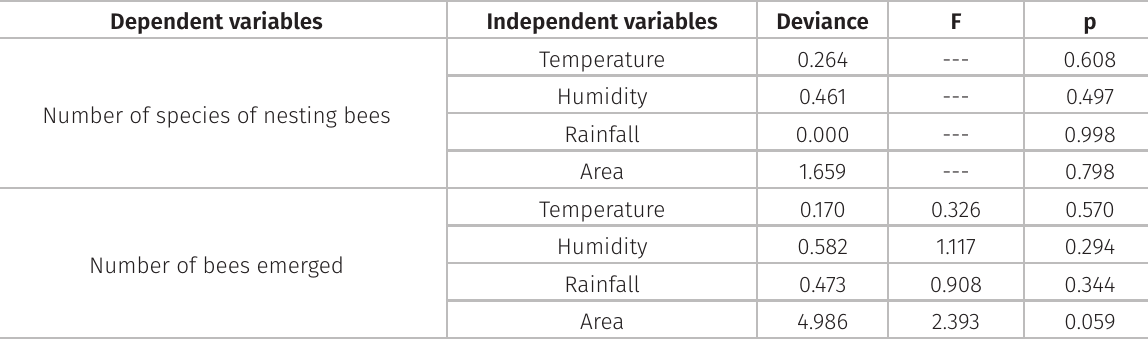
Table II. Results of generalized linear model performed to explain the relation among the environmental variables, number of nesting bee species and number of emergent bee species.